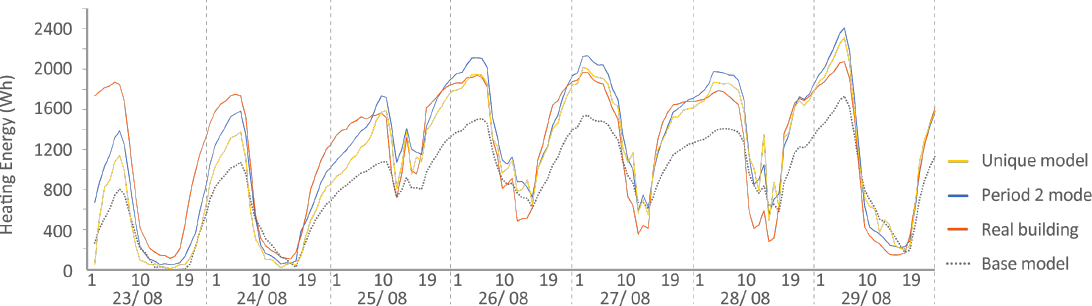
Figure 16. Energy consumed by house O5, Period 2 (set point at 30 ◦ C). Period 2 model: CV(RMSE): 21.75%, NMBE: 0.02%, and R 2 : 83,78%. Base model: CV(RMSE): 39.77%, NMBE: 0.24%, and R 2 : 69.18%. Unique model: CV(RMSE): 28.41%, NMBE: 0.02%, and R 2 : 74.18%.